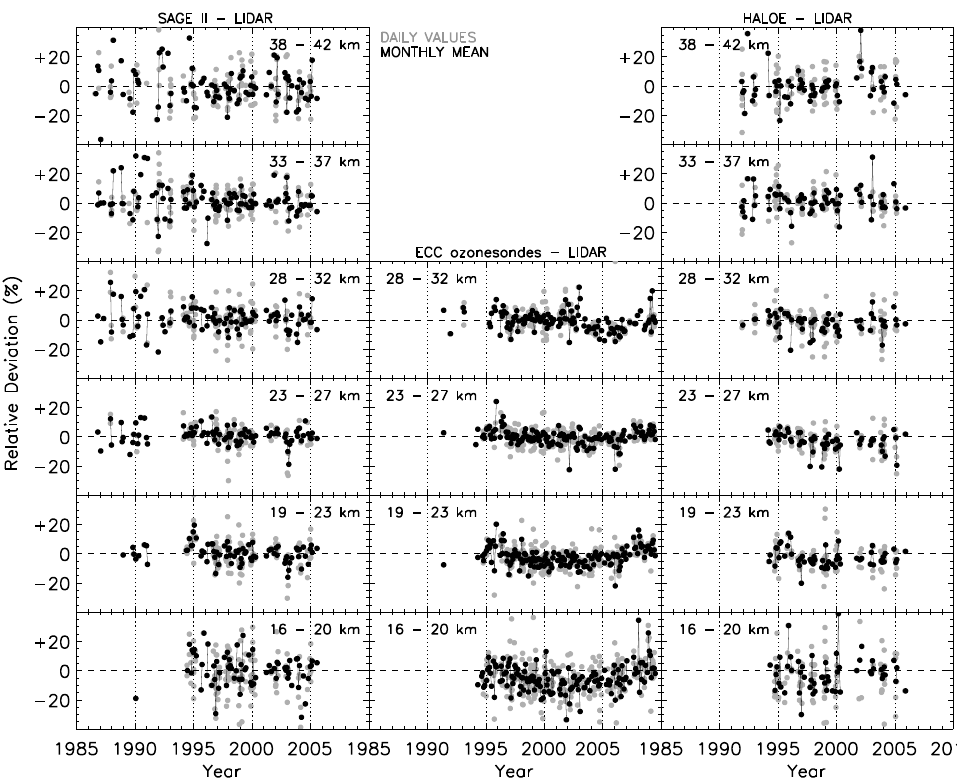
Fig. 3. Comparison of lidar ozone profiles coincident with SAGE II (left panel), ozonesondes (middle panel) and HALOE (right panel). The black solid circles represent the monthly mean of the relative differences and grey solid circles represent daily values. The dashed horizontal lines represent 0% and the dotted vertical lines represent year 1990, 1995, 2000, and 2005.